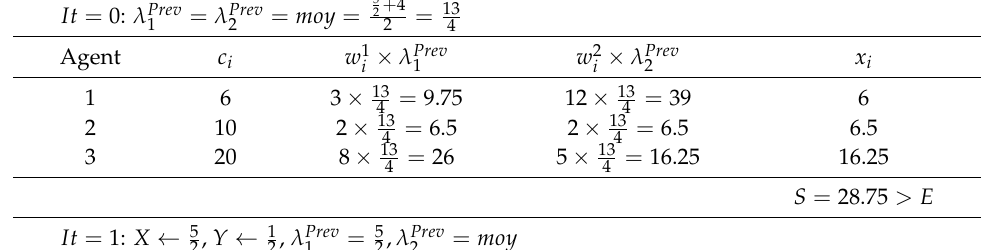
← { 1 ← { 2, 5 ,5 } and λ S ,4,5 } 2 2 2 1